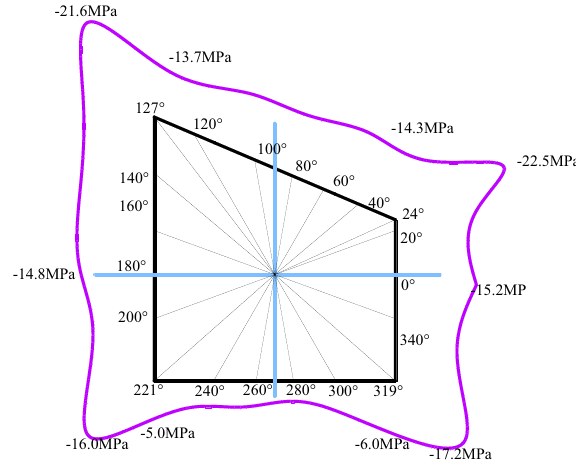
Figure 8. Stress distribution law of roadway surrounding rock.